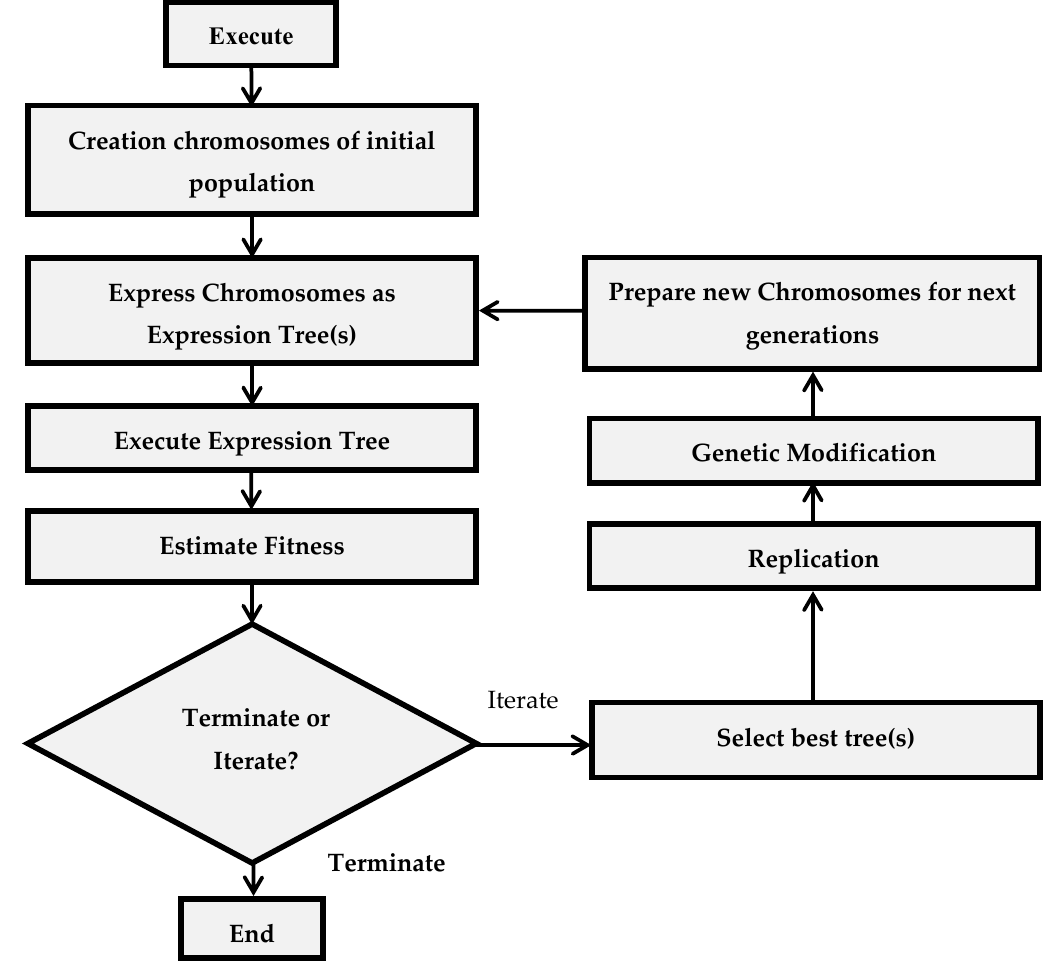
Figure 1. Simple illustration of the of the gene expression programming (GEP) algorithm [22].